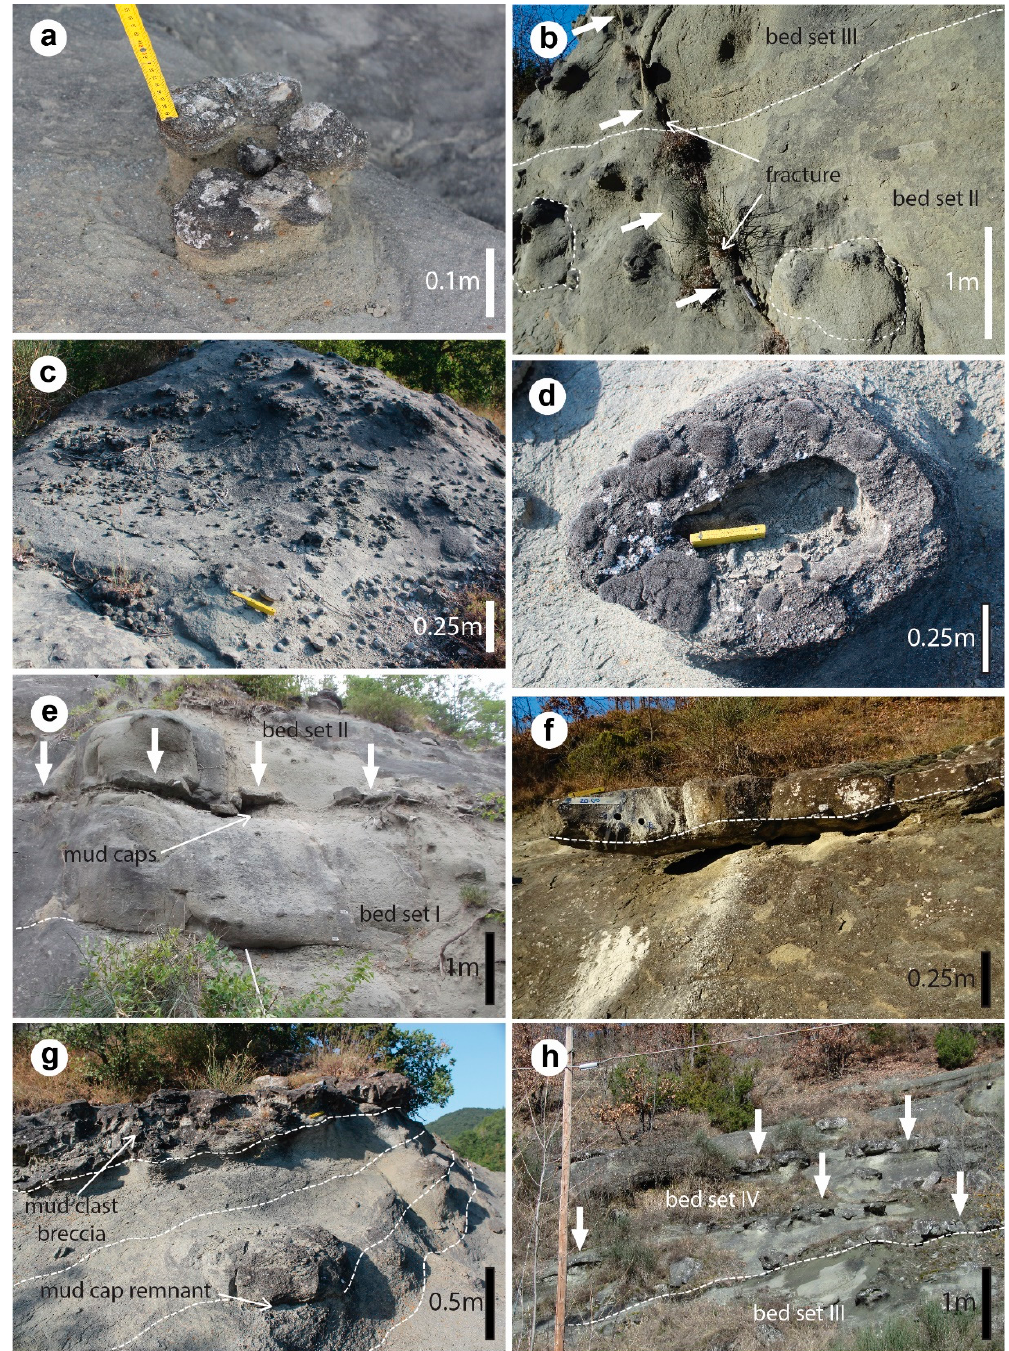
Figure 7. ( a ) Coalescing cm ‐ scale equant concretions; ( b ) Elongated concretions (arrows) developed parallel to fractures and composite shapes (dashed white line) resulting from coalescence of smaller concretions; ( c ) cm ‐ scale concretions from the upper finer grained part of bed set II; ( d ) Equant concretion with a marlstone rip ‐ up at its core; ( e ) and ( f ) show highly elongated strata bound concretions (indicated by arrows in e ) developed either above a turbidite mud cap and straddling an amalgamation surface, respectively. In ( e ), note the contrastingly poorly cemented nature of the base of the uppermost bed from bed set I despite its vertical association with a mud cap; ( g ) Composite concretions developed across an amalgamation surface (below) and marlstone clast breccia forming a highly elongated concretion several m ‐ long; ( h ) highly elongated concretions (highlighted by arrows) from the upper axial part of CdV.